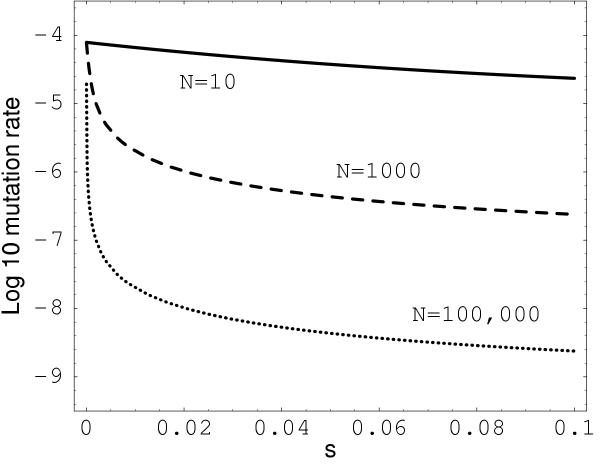
Estimate of mutation rate when positive selection is acting. The estimate  is plotted on a logarithmic scale in base 10. Solid curve: N = 10; Dashed; N = 1000; Dotted: N = 105.